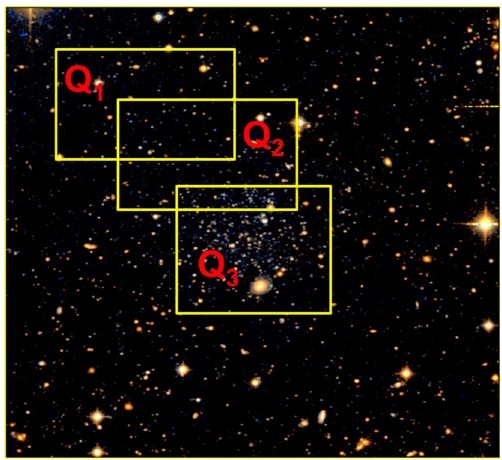
Fig. 1 Series of sequential queries generated in a data